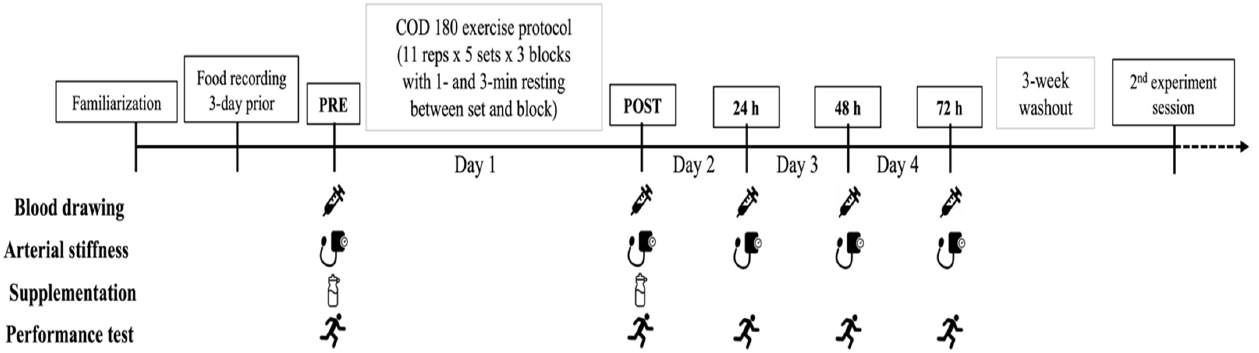
Figure 1. A schematic illustrating an overview of the experimental procedures of the present